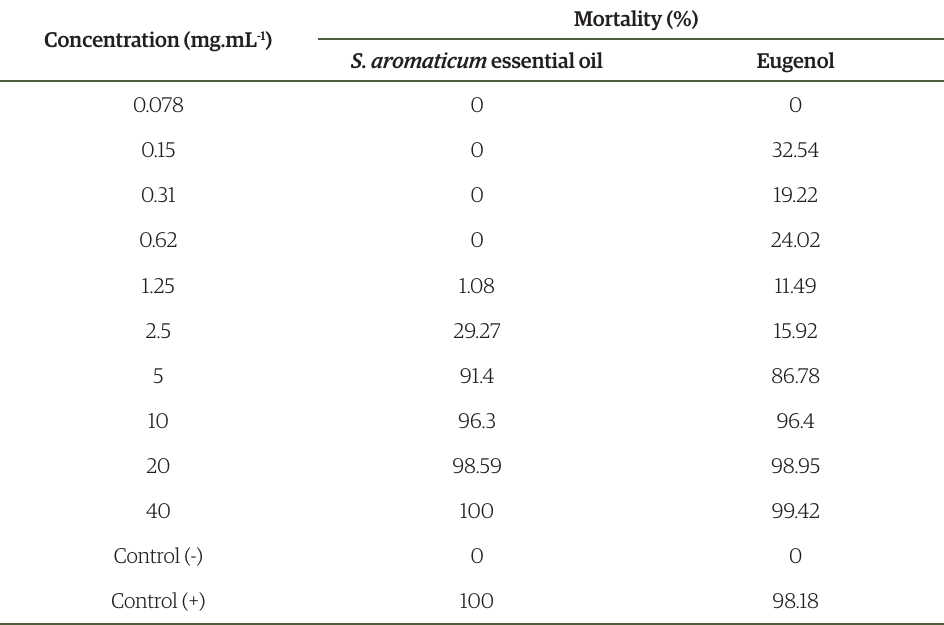
Table 1. Percentage mortality of non-fed larvae of Rhipicephalus sanguineus exposed to the essential oil of Syzygium aromaticum and